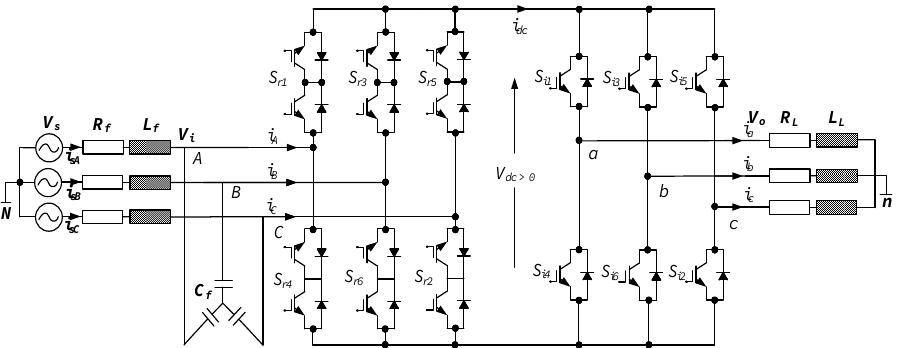
Figure 1. Power circuit of the two-stage matrix converter (TSMC) system.